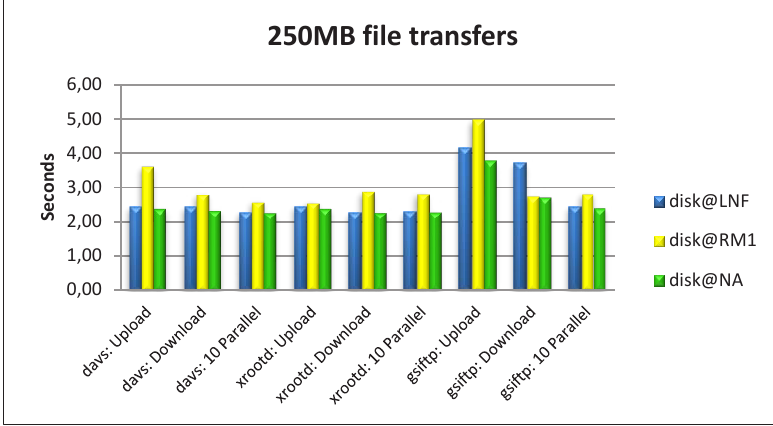
Fig. 3. Time to upload and download a 250MB file from the three disk servers with xrootd, davs